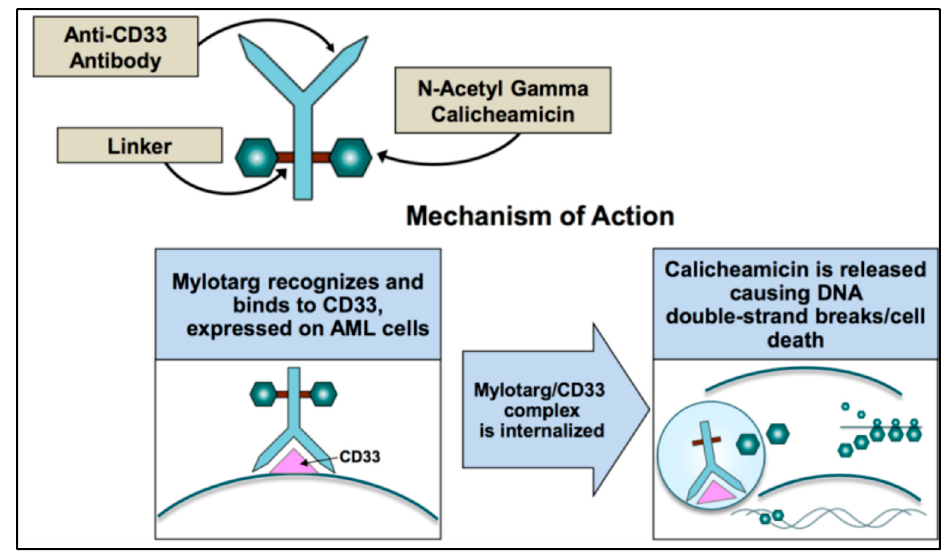
Figure 1. Mechanism of action of gemtuzumab ozogamicin.